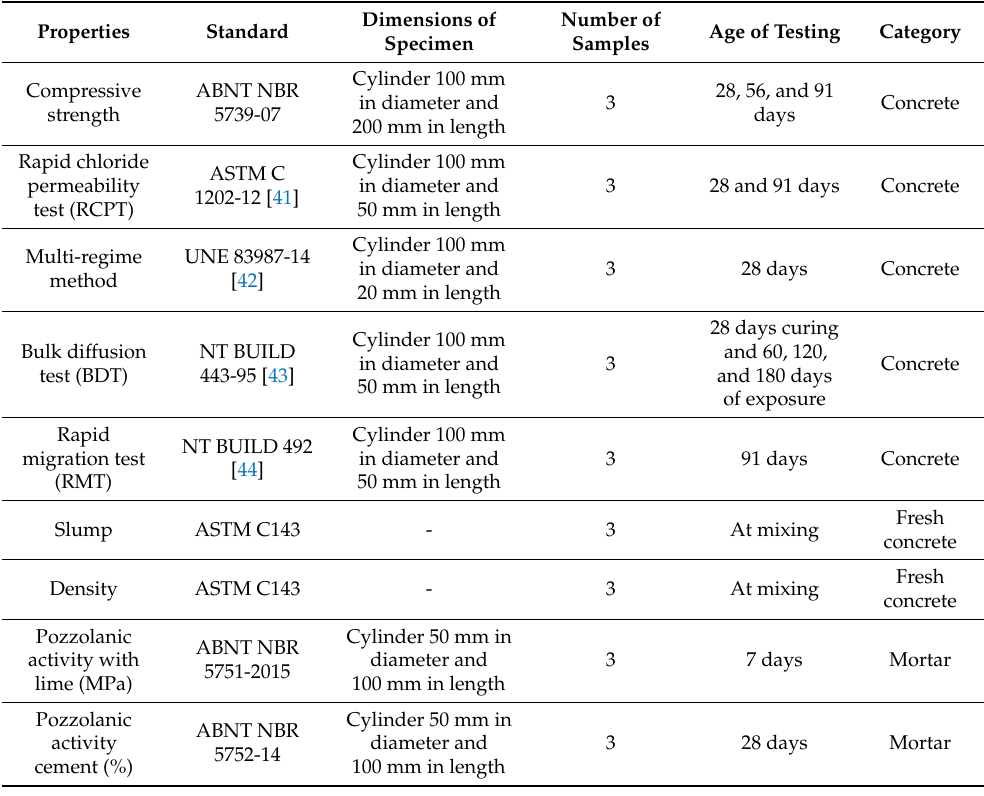
Figure 9. Durability tests on concrete samples. Table 3. Dimensions, number of samples, and experimental age of the samples.